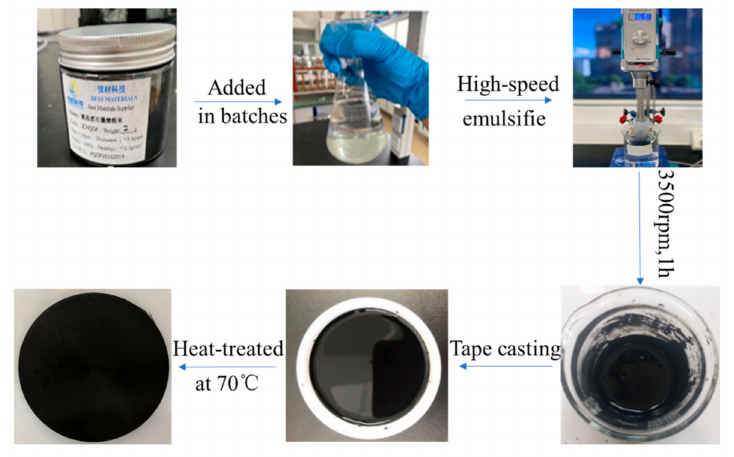
Figure 1. Schematic diagram of the fabrication process of G-TPU composite